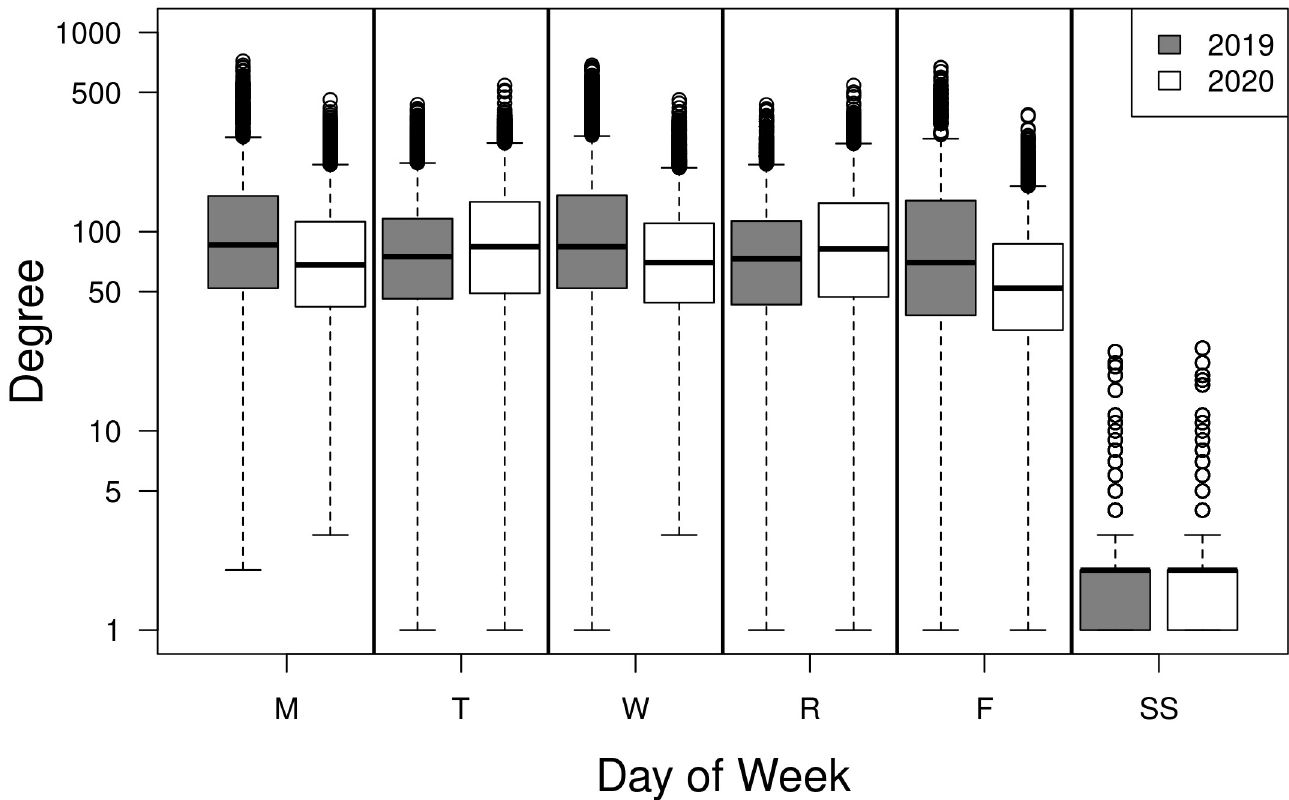
Fig 3. Degree distributions for college networks by day for fall 2019 and spring 2020 semesters. Weekday networks include both enrollment and housing connections for both the fall 2019 and spring 2020 semesters. The weekend networks (“SS”) include only the housing connections. Degree values all were increased by one and shown on a semi-log